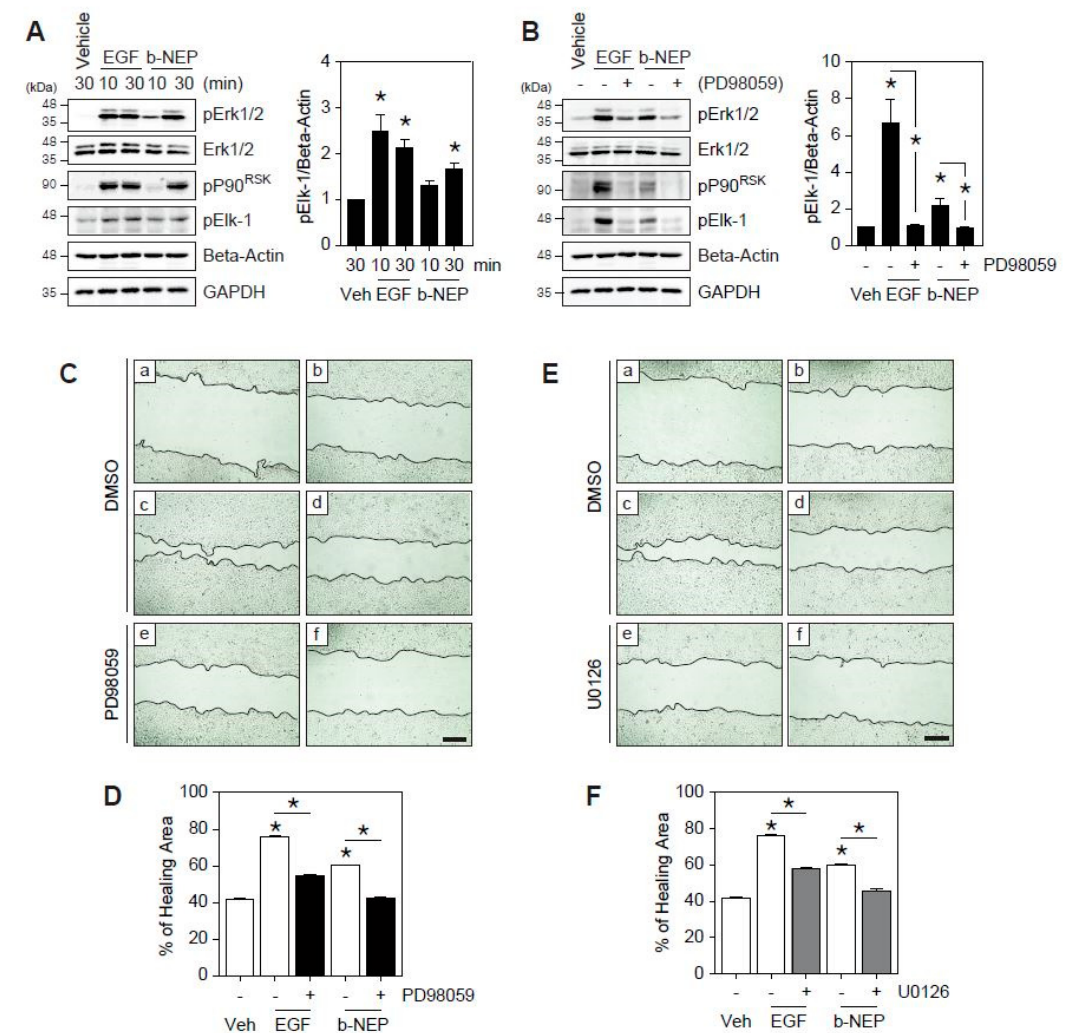
Figure 2. β -NEP regulates cell migration through mitogen-activated protein kinase (MAPK)/Erk1/2 activation during wound healing. ( A ) HaCaT cells were treated with EGF, β -NEP, or vehicle for indicated time periods. Cells were subjected to Western blotting with anti-Erk1/2, phospho-Erk1/2, phospho-P90 RSK , and phospho-Elk-1antibodies. The graph on the right shows the intensity of phospho-Elk-1 normalized to anti-Beta-Actin (* p < 0.05, Student’s t -test). ( B ) Cells were treated with